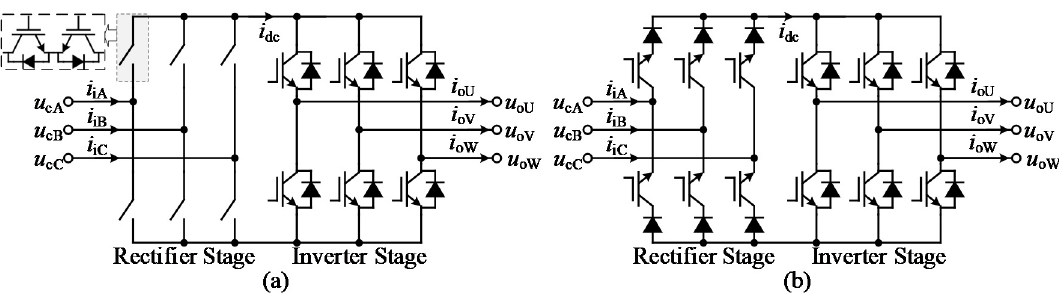
Figure 1. Topologies of the indirect matrix converter ( a ) and the unidirectional matrix converter (UMC) ( b ). Nevertheless, the stability issue has subordinate priority in the control goal of existing